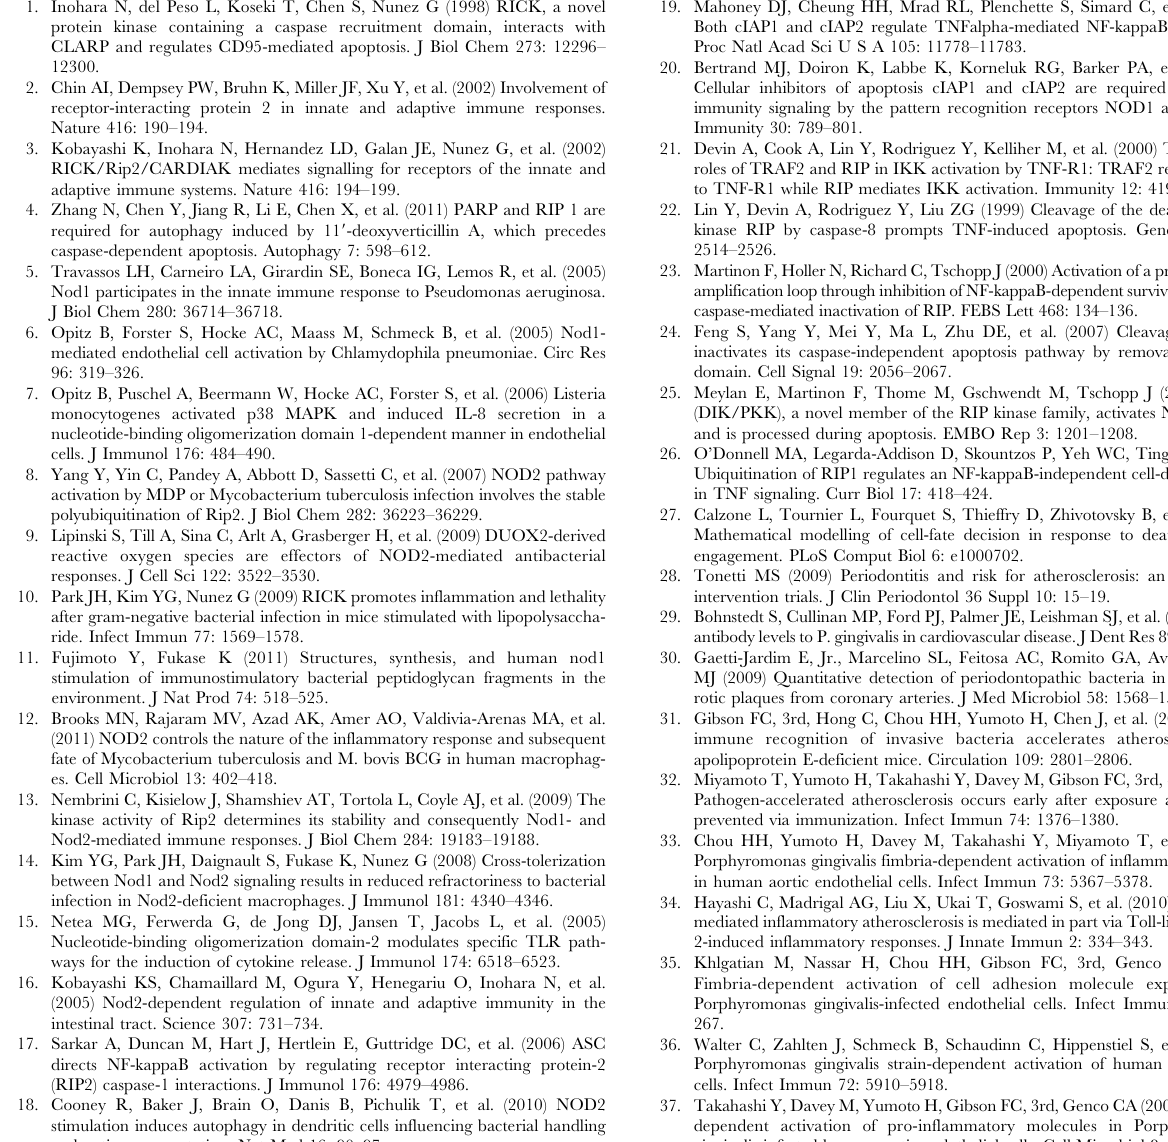
Table S1 Bacterial strains used in this